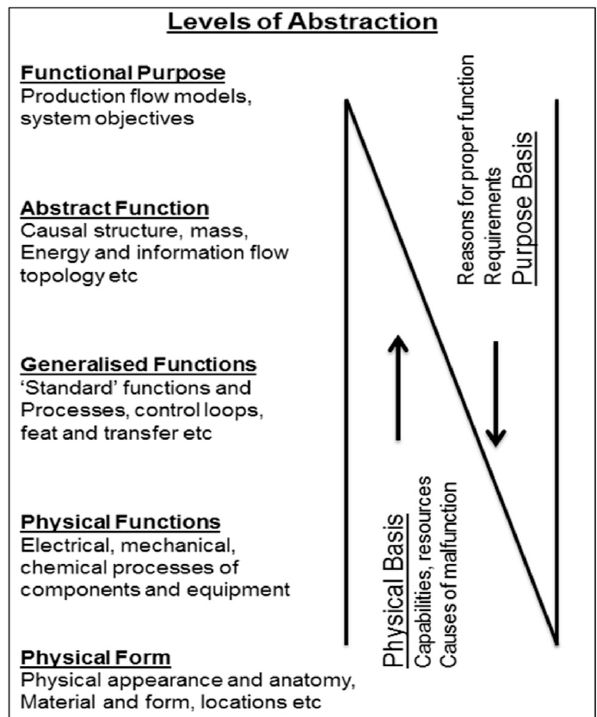
Figure 3. The Levels of Abstraction Hierarchy by Rasmussen (source: [10]).